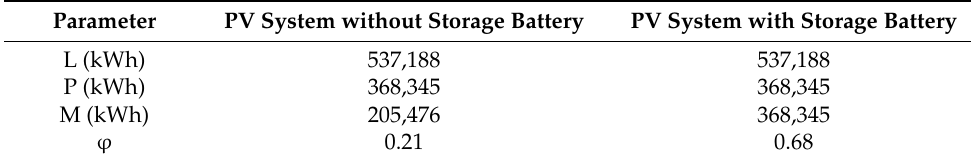
Table 5. Value of the matching index for the PV system without and with storage battery.